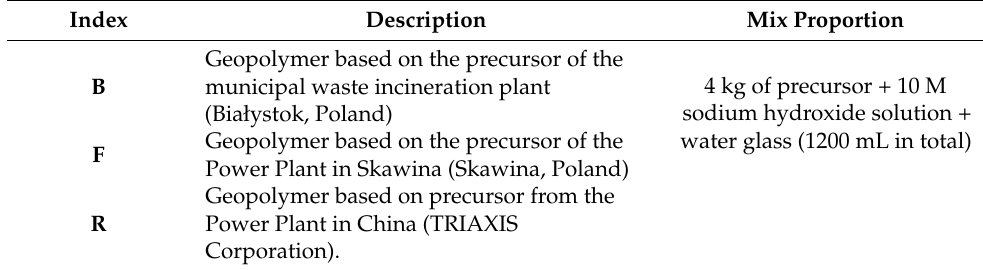
Table 2. List of manufactured